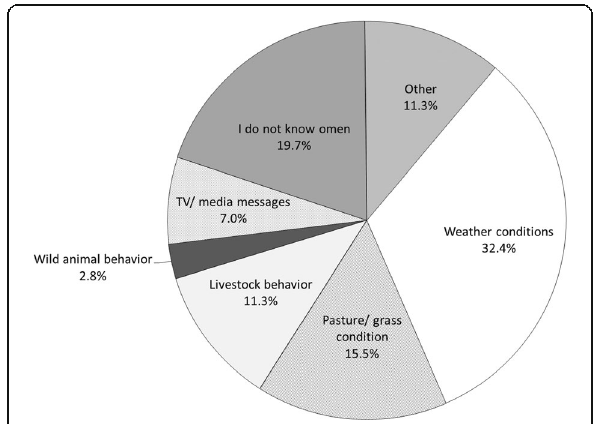
Figure 4 Sources of information and omen indicating dzud to 50 interviewed herders in the Mongolian Altai. Multiple answers were